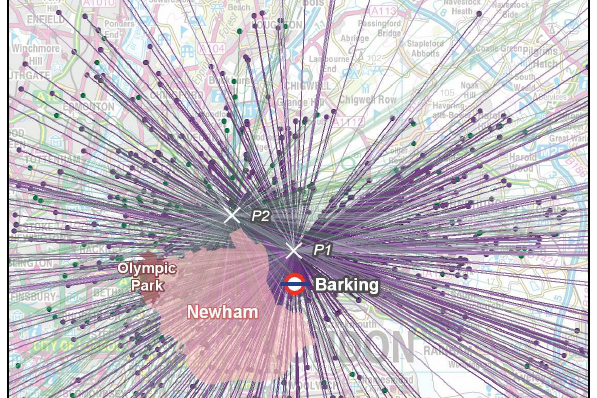
Figure 8. Geographic Mean of Potential Coach